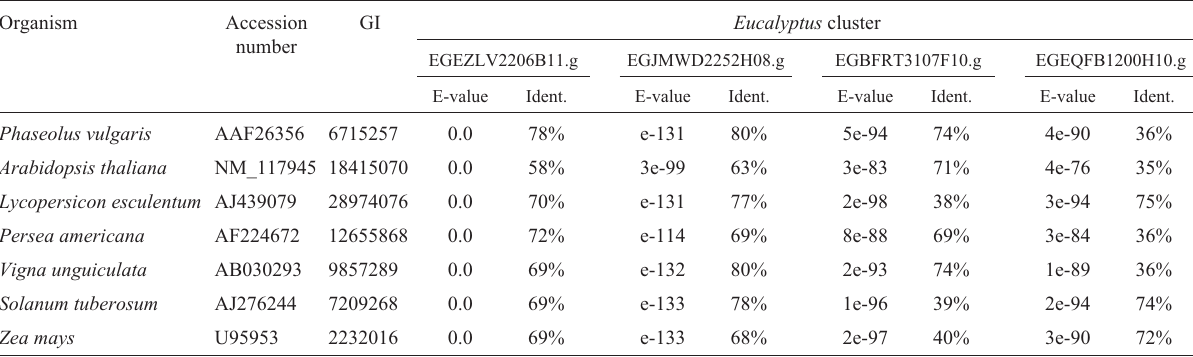
Table 1 - Similar clusters to the NCDE gene, found in the FORESTs database.